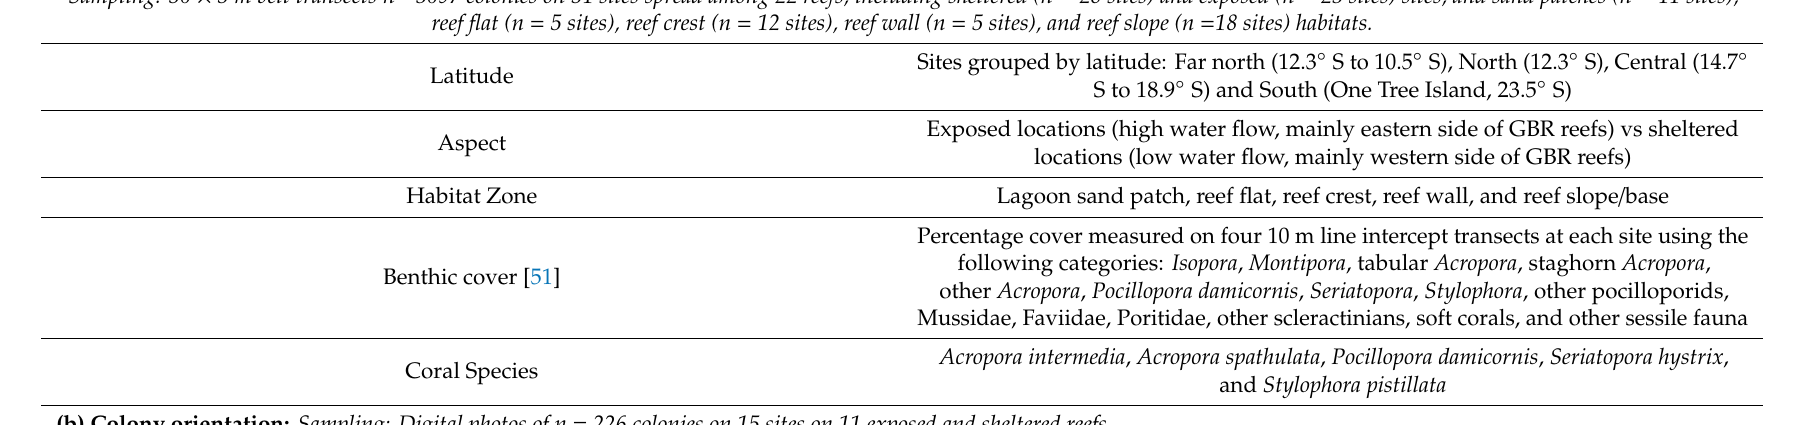
(b) Colony orientation: Sampling: Digital photos of n = 226 colonies on 15 sites on 11 exposed and sheltered reefs Crevice—colony grew within a crack in the reef matrix; Open—colony is on flat reef Colony Orientation [52] (Position of Coral on Substratum) benthos without any obvious shading by competitors; Sand—colony grew above a sand patch; Underhang—colony was shaded by reef matrix or other colonies (c) Colony structure: Sampling: Digital photos of n = 226 colonies on 15 sites on 11 exposed and sheltered